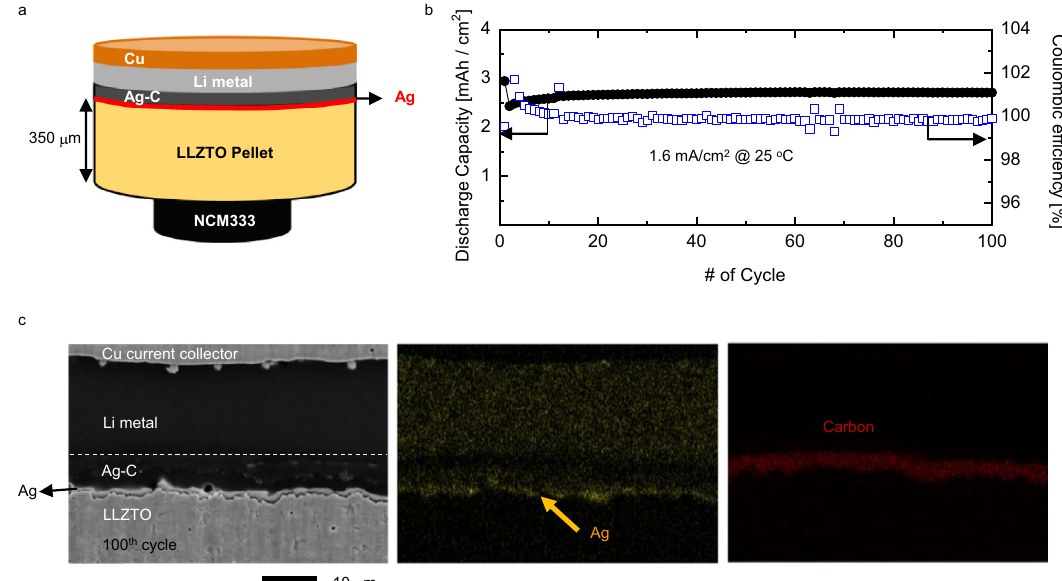
Fig. 4 | Electrochemical performance of Li|Ag-C/Ag/LLZTO/IL|NCM333 (3.2mAh/cm 2 )single-layerpouchcell.a SchematicofassembledcellusingLLZTO pellet. A relatively small cathode (0.4cm in diameter) was used to eliminate the possibility of directcontact between the ionic liquid and lithium metalfor the cell.